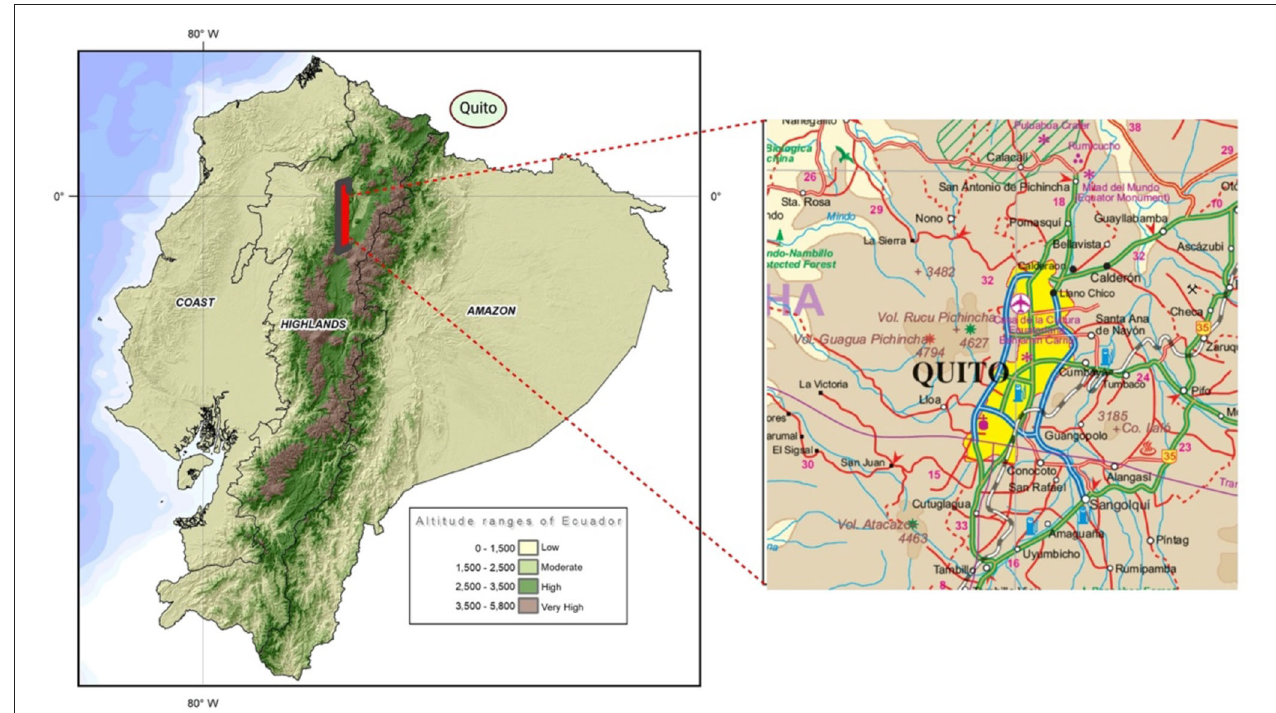
FIGURE 1 | Map location of the population of study: 163 special forces police officers located in Quito, the capital city of Ecuador in the province of Pichincha (Highlands or Andean